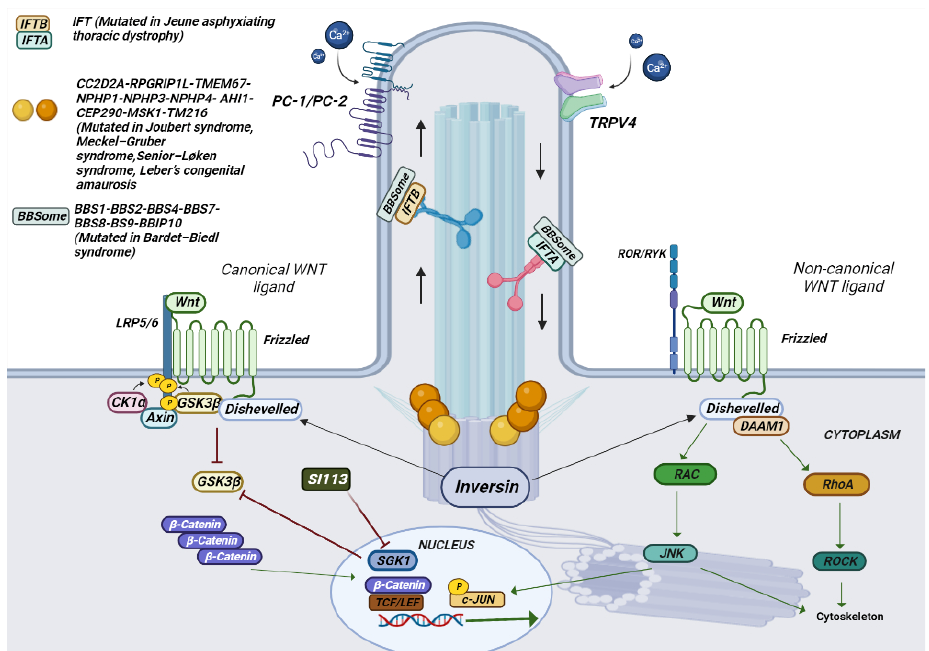
Figure 4. Schematic representation of the composition of a cilium and the various mutated genes in ciliopathies. In the photo it is possible to observe how a cilium is structured in its various components. The different genes mutated in ciliopathies, and their location are represented.